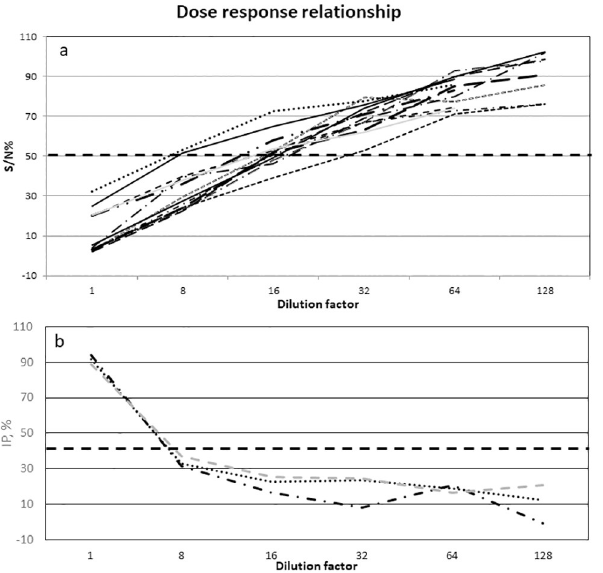
Fig 3. Dose-response relationship using the commercial ID Screen 1 Rift Valley Fever Competition multi-species kit (ID.Vet, France). (a) ID Screen 1 Rift Valley Fever Competition Multi-species and (b) INgezim FVR Compac. CP stands for competition percentage, IP for Inhibition percentage. Dash lines correspond to the positive threshold.